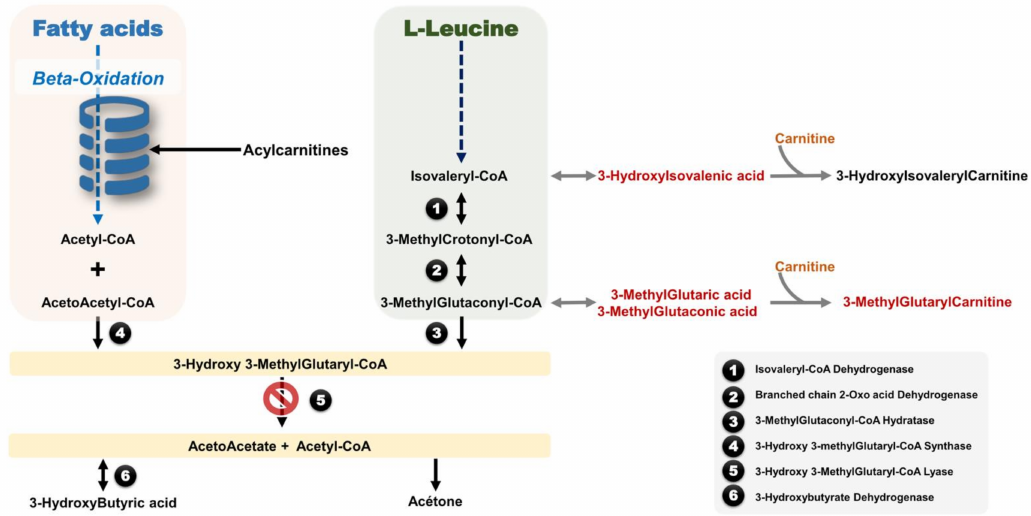
Figure 1. Overview of the involved metabolic pathways in the 3-Hydroxy-3-methylglutaryl-CoA Lyase (HMG-CoA Lyase)